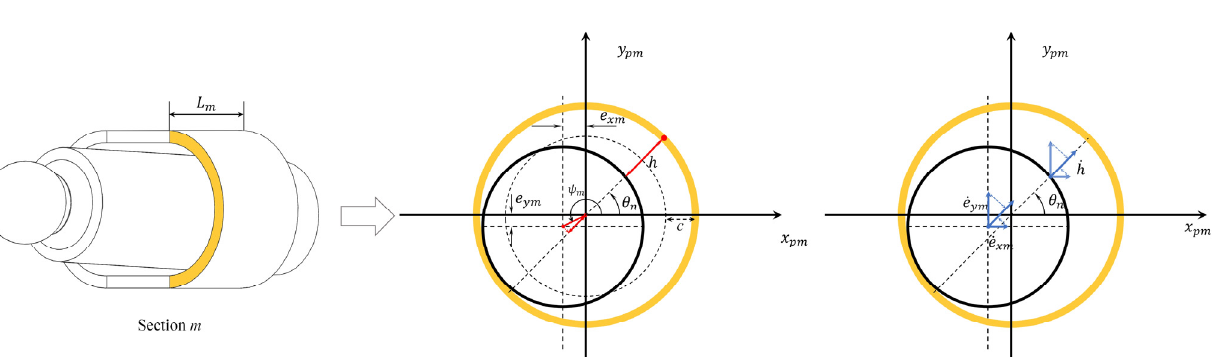
Figure 3. The fluid film in a rectangular coordinate system In the rectangular coordinate system, the coordinates of the point can be expressed as: